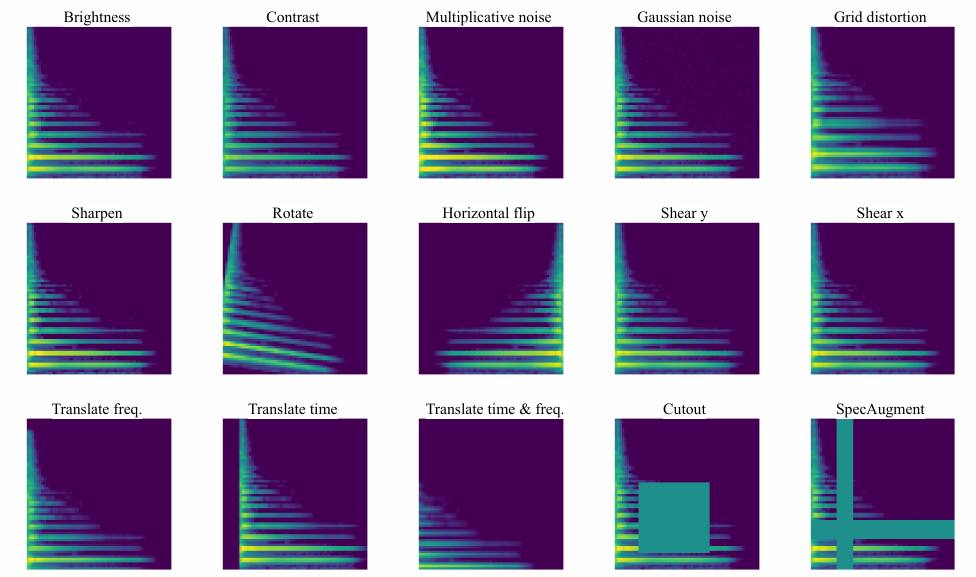
Figure 2. All augmentation techniques with random magnitude applied to one example from the NSynth dataset with mel bands on the y (0 to 64) and time frames on the x axis (beginning to the end of the